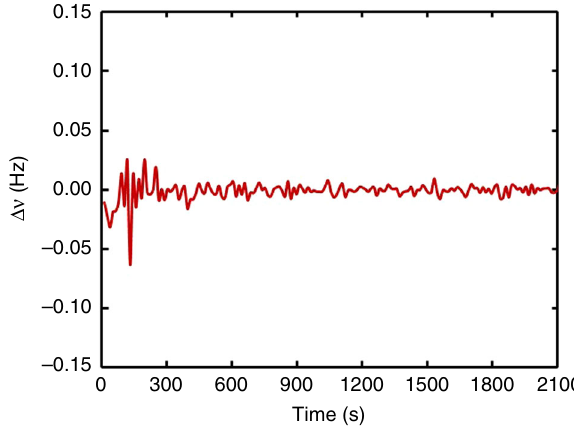
Fig. 5 The error signal fed to the frequency of microwave source. Deviation of the microwave frequency from the atomic transition after locking the clock signal to the DDS of the microwave source. The servo loop is activated at time t = 0